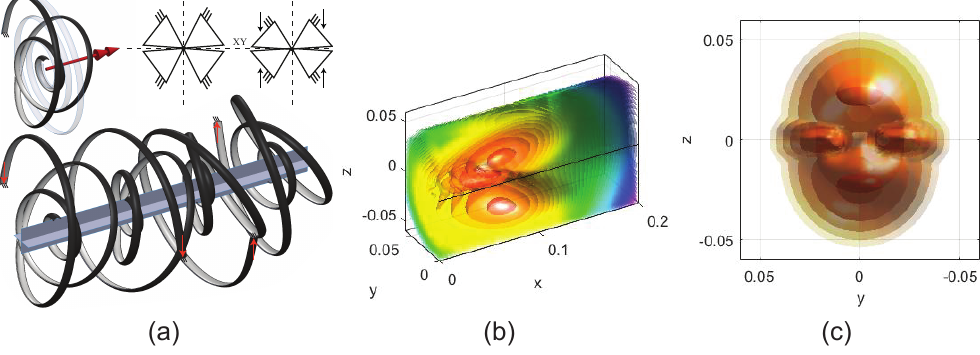
Figure 11. An octo-stable system is obtained by connecting four mirrored spirals (arc-section, quasi-isotropic material, 1.3 θ c prestress) to a central shuttle and by displacing the clamped outer ends. (a) An illustrative embodiment is shown. (b) , (c) Four distinct energy minima are visible in the PEF of the total system that including their counterparts in the negative x -direction reveal an octo-stable system.